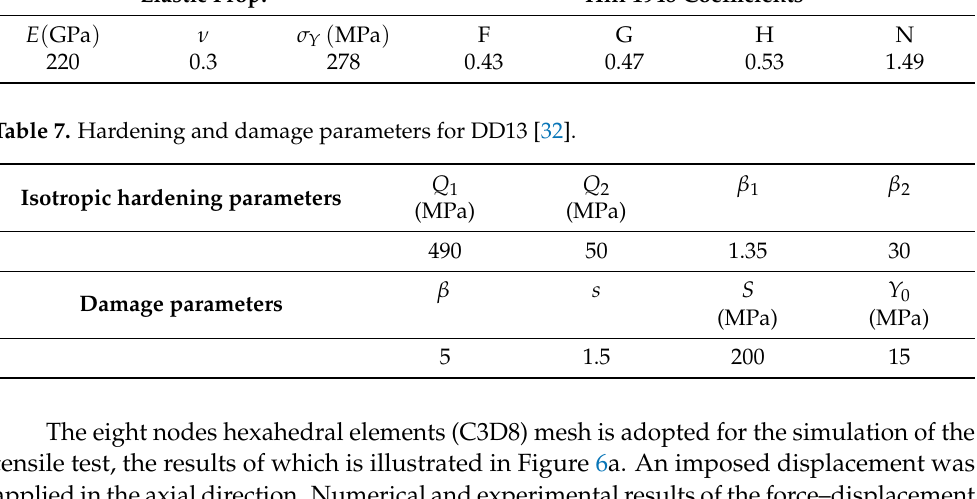
Figure 7. Experimental and numerical force–displacement curves. 4.4. Numerical Simulation of Cross-Die Deep Drawing Test Cross-die deep drawing simulation is carried out in this section. This test is used to cover a wide range of stress states and to reproduce most significant strain paths that can be found in deep drawing, i.e., tensile, shear, plane strain, and biaxial loading modes. An improved elastoplastic model strongly coupled with damage effect in the yield function and plastic potential is used. The developed model is implemented in ABAQUS software via the VUMAT subroutine. For the simulation, a 3D finite element model is performed in Abaqus software to analyze the cross-die test. The die, punch, and blank holder are defined as discrete rigid parts, and the sheet was assigned as a deformable homogenous shell. The initial dimensions of the square blank sheet were equal to 260 × 260 × 1 mm 3 . A four nodes quadrilateral shell element S4R with a size of 5 × 5 mm 2 and with five integra- tion points through the thickness was employed for meshing the sheet. Penalty contact is used in forming simulations. The Coulomb friction coefficient of 0.05 was considered be- tween sheet and tools surfaces. The blank holding force during forming was 450 kN. The punch stroke of 60 mm was considered in the simulation. Figure 8 shows the main geo-